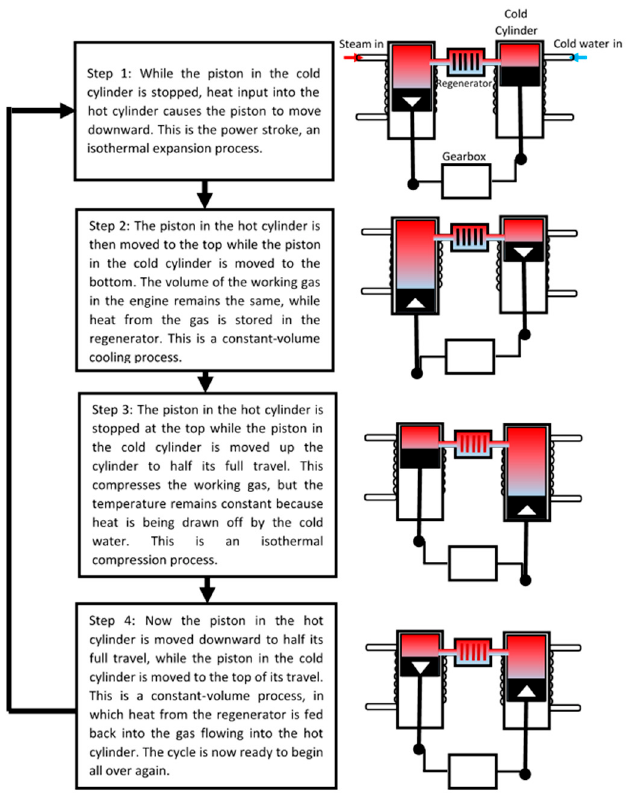
Figure 5. Schematics showing the basic working principle of Stirling Refrigeration.